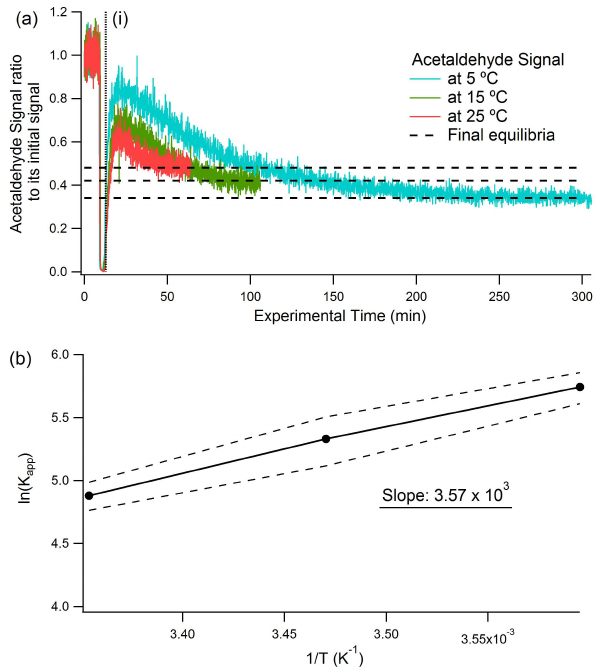
Fig. 7. Typical acetaldehyde time profiles at 5, 15 and 25 ◦ C are shown in (a) . The ratios of signal at a given time to the initial signal are shown. H 2 O 2 (13.3mM) was injected to the 10mM acetalde- hyde solutions at time (i). The dashed lines show the signal levels at equilibrium. The van ’t Hoff diagram for 1-hydroxyethyl hydroper- oxide (1-HEHP) formation from acetaldehyde is shown in (b) . The dashed lines connects + 1 σ and − 1 σ from the average ln (K app ) de- termined at the three